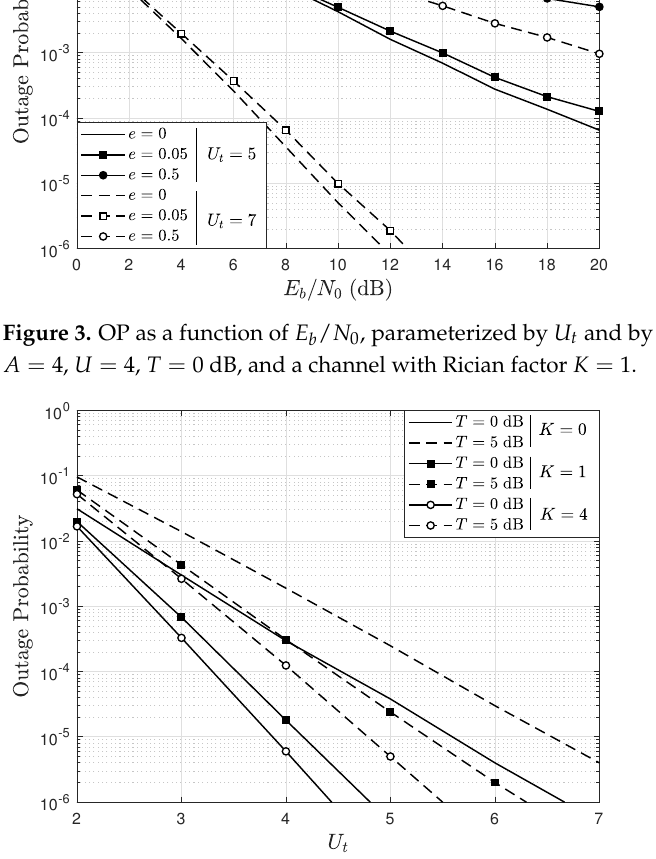
Figure 4. OP as a function of U t , parameterized by K and the threshold T , considering BPSK modulation, A = 2, U = 2, and e =